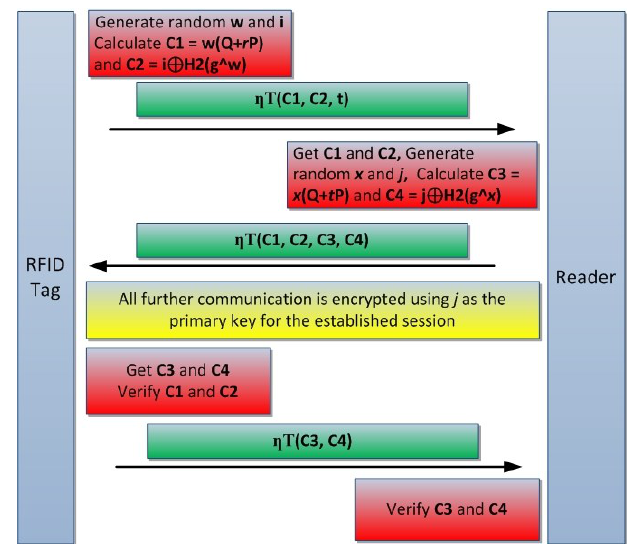
Figure 1. RFID-Tate Scheme, reproduced from